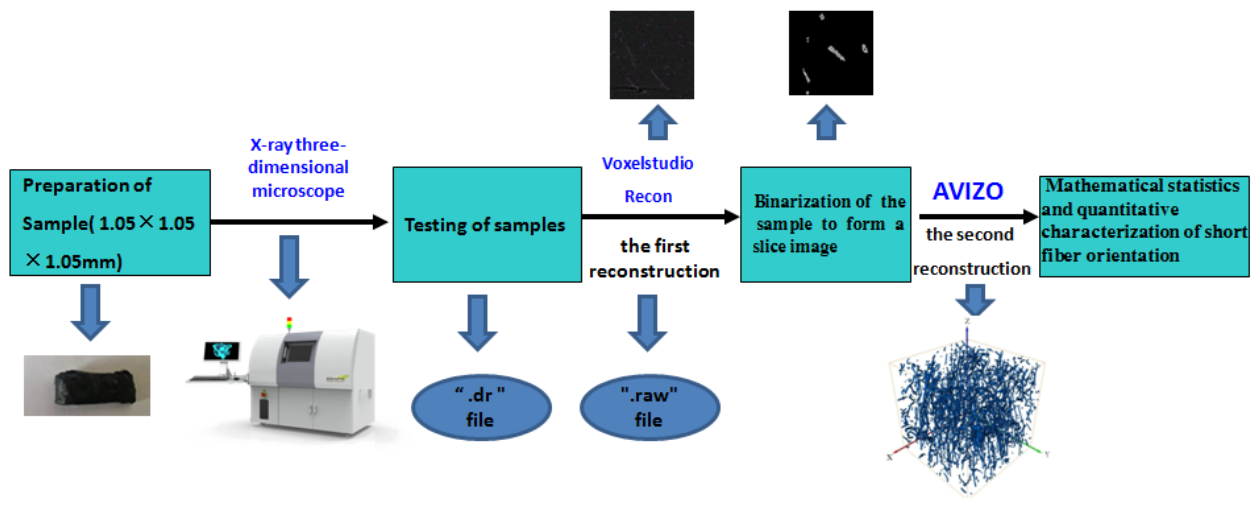
Figure 3. Three-dimensional reconstruction process of polyester fibers.